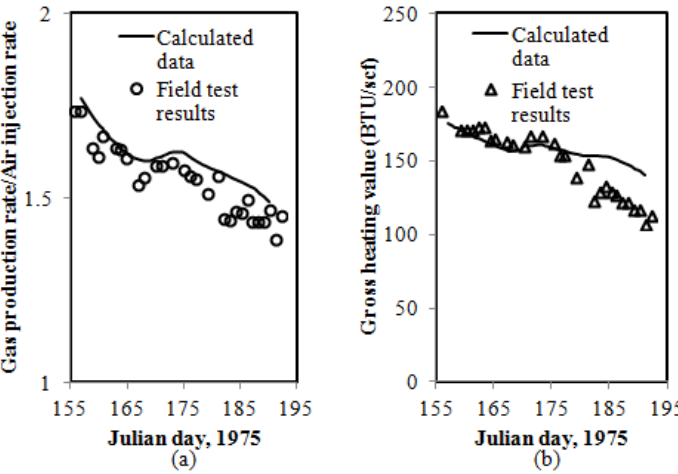
Figure 17. Comparison of calculated data and field test: ( a ) gas production/air injection ratio and ( b ) gas heating value [45].